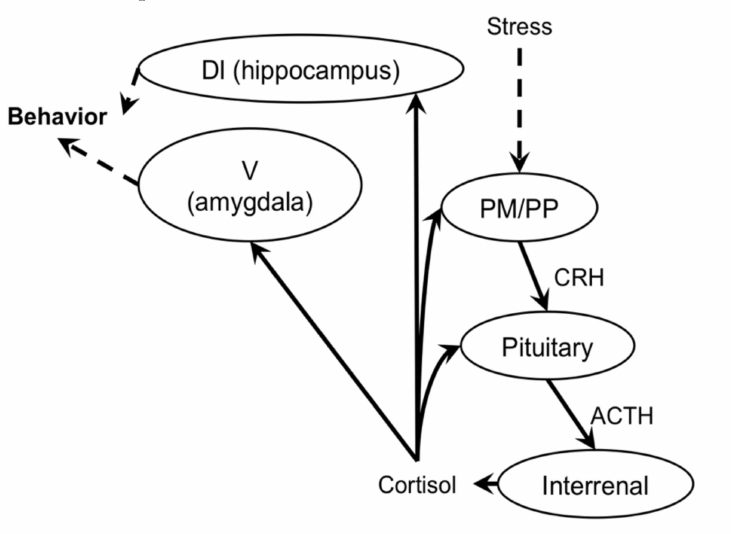
Figure 4. Hypothalamus–pituitary–interrenal axis activation by stress and behavioral modification in fish. The magnocellular preoptic nucleus (PM) and parvocellular preoptic nucleus (PP) of the hypothalamus are stimulated to express corticotropin-releasing hormone (CRH) and possibly vasotocin / isotocin following exposure to stressful stimuli. Binding of CRH causes release of adrenalcorticotrophic hormone (ACTH) from the pituitary gland, which then induces release of cortisol from the interrenal gland. Cortisol binds to GR / MRs in the commissural and subcommissural nuclei of the telencephalon (V; putative fish homologue to the mammalian amygdala) and the ventral parts of the lateral zone of the dorsal telencephalon (DI; putative fish homologue of the mammalian hippocampus) to modulate behaviors such as the aquatic preference of mudskippers. In the central nervous system, cortisol also functions at the level of the pituitary gland and the PP / PM. Dashed lines indicate possible